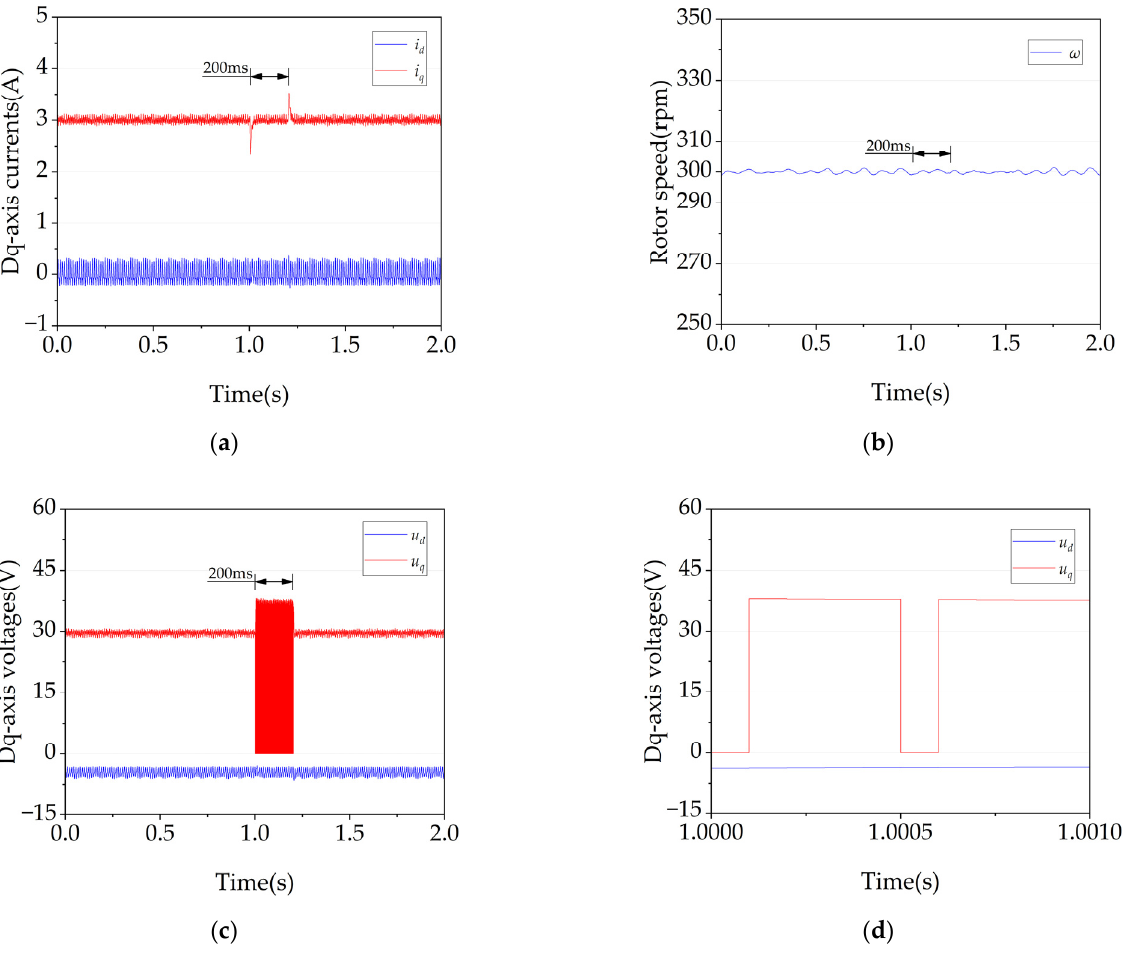
Figure 4. Waveforms of PMSM with and without injection of zero-voltage perturbation ( N = 5, i d = 0, i q =3 A, 300 rpm). ( a ) Dq -axis currents; ( b ) rotor speed; ( c ) Dq -axis command voltages within 2 s; ( d ) Dq -axis command voltages within 10 cycles of PWM switching. − 15